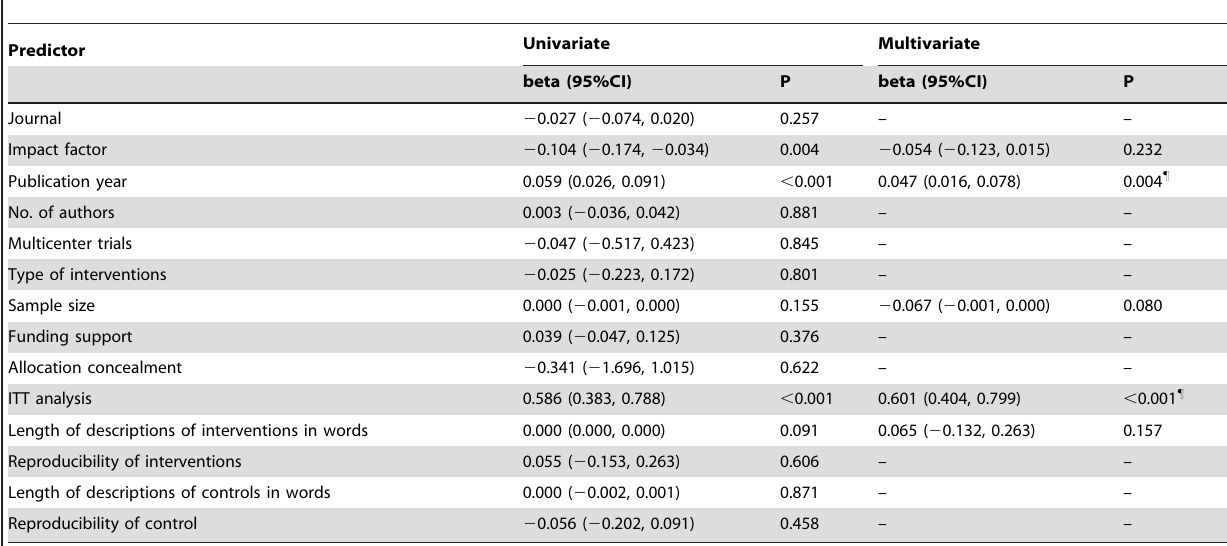
Table 3. Results of linear regression for predictors associated with CONSORT methodological